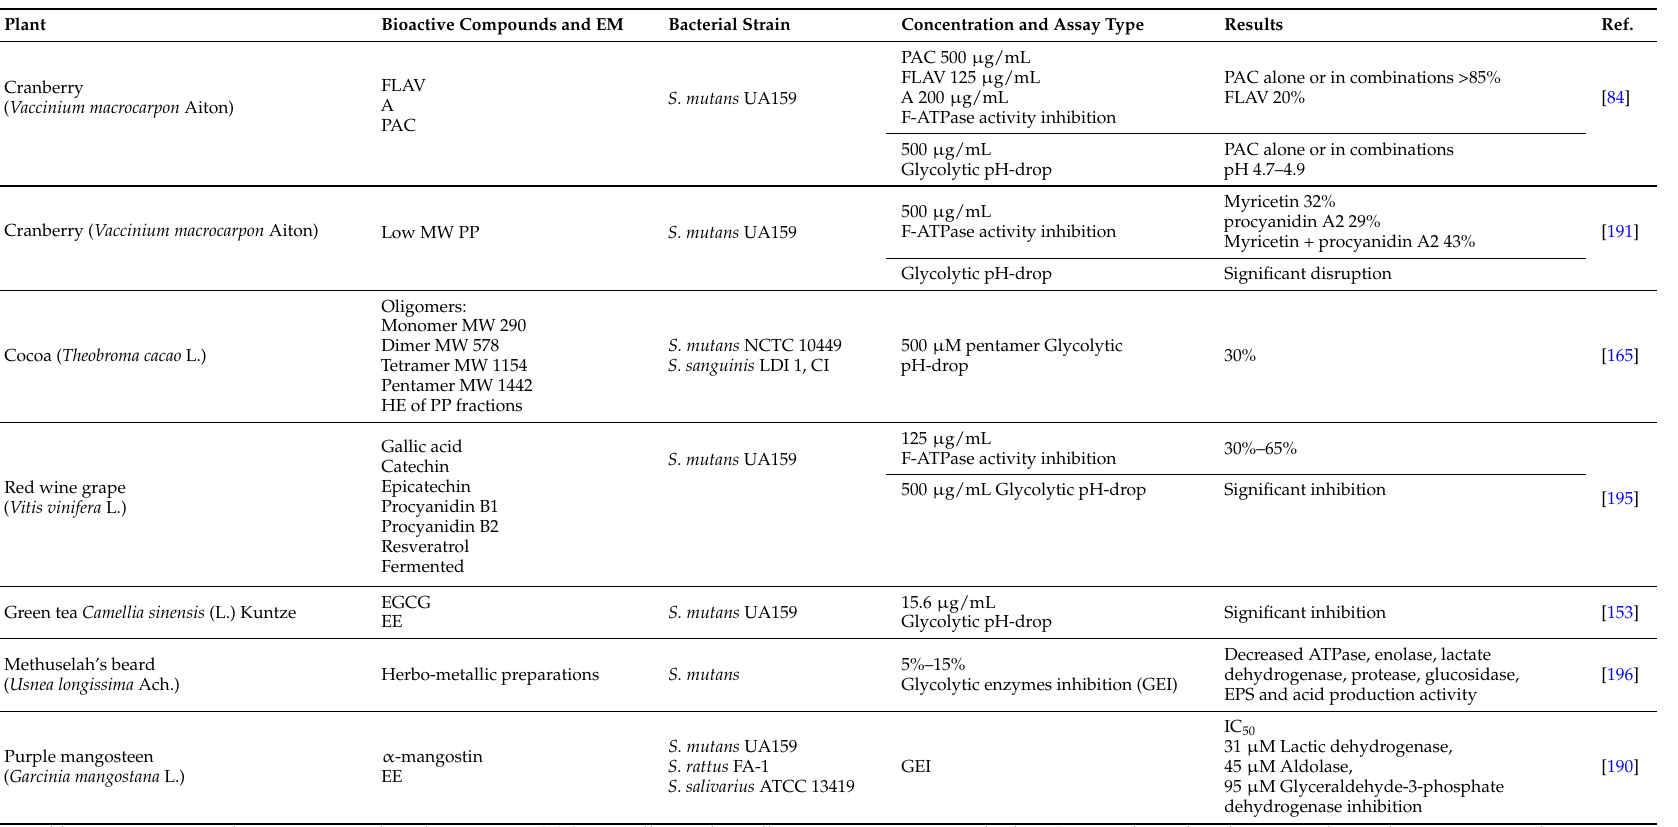
Table 6. Inhibitory effects of phytochemicals on F-ATPase activity and glycolytic